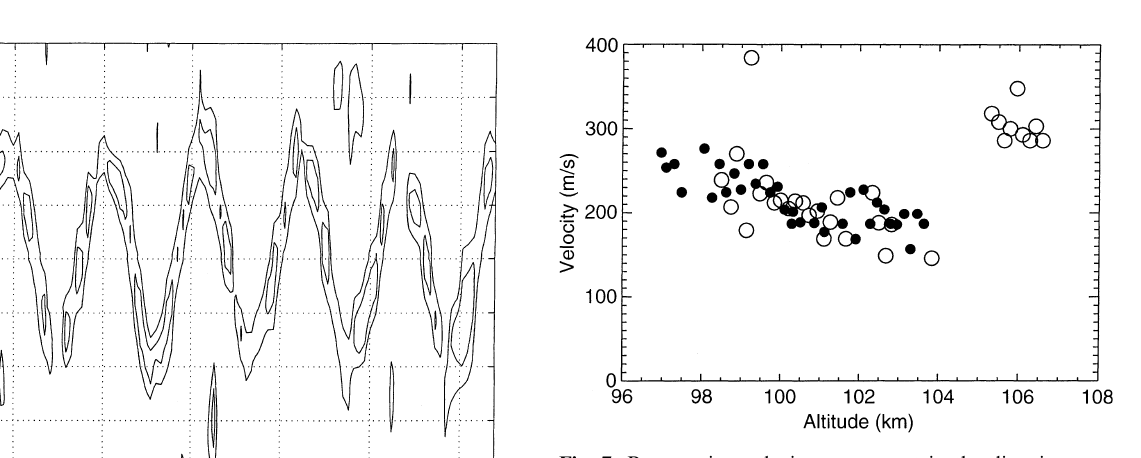
Fig. 7. Propagation velocity component in the direction perpendic- ular to the rocket axis obtained from the maximum time-delay of cross-correlation of the signals U 1 and U 2 , see also Fig. 6. The results are shown as a function of altitude. Open circles are for upleg conditions, filled circles for downleg. A possible uncertainty for the interpretation arises from vibrations in the booms of the detecting probes. As the RMS-level of the fluctuations varies gradually with altitude we may exclude wave nonlinearities as the cause of the abrupt change in phase velocity observed at upleg conditions